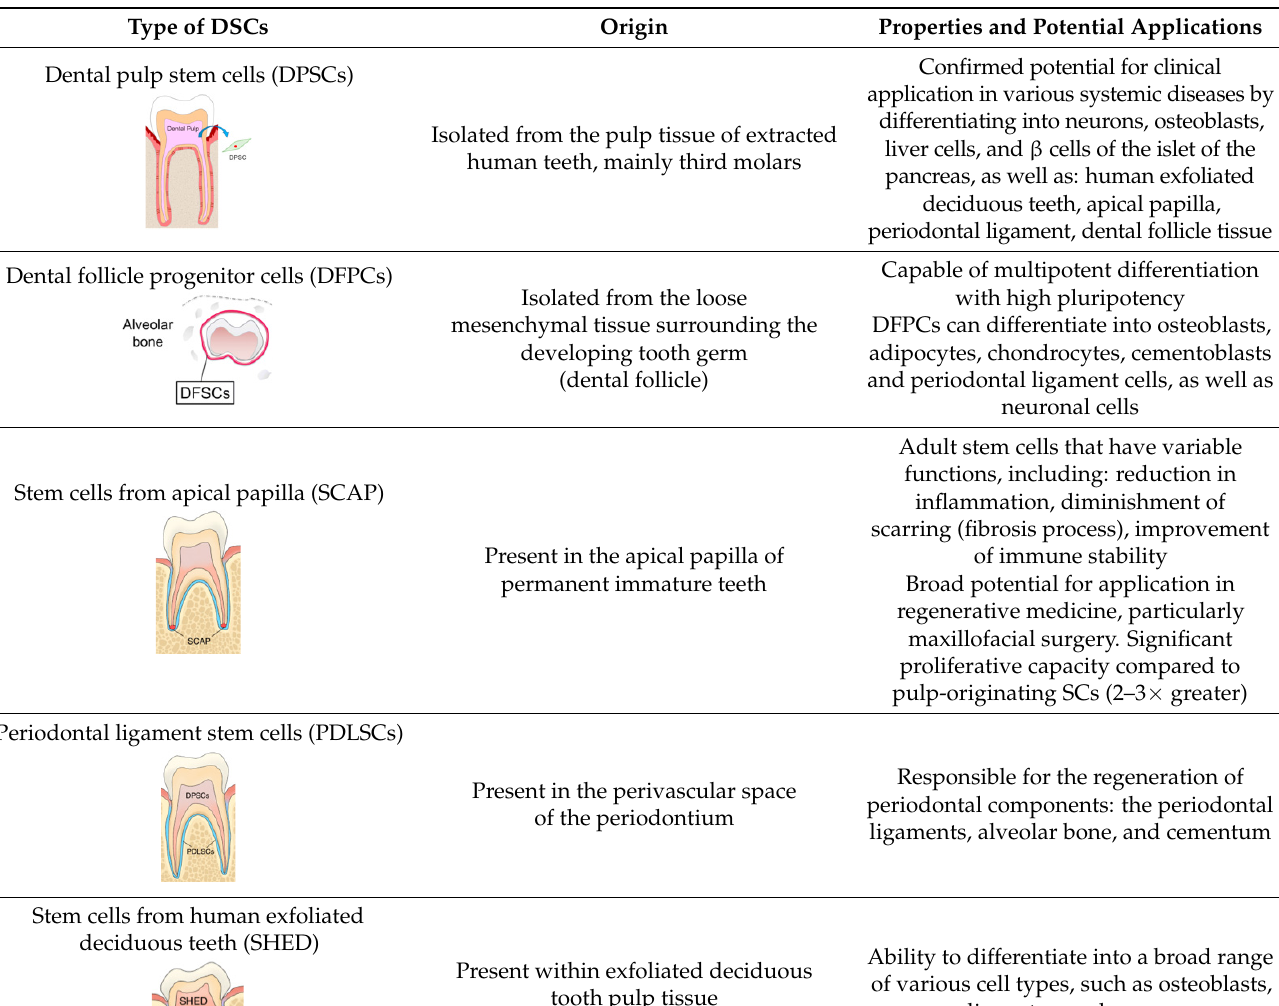
Table 2. Types of stem cells (DSCs) originating from the oro-facial and maxillofacial area. Origin (primary isolation), biological properties, and potential application in regenerative dentofacial orthopedics.